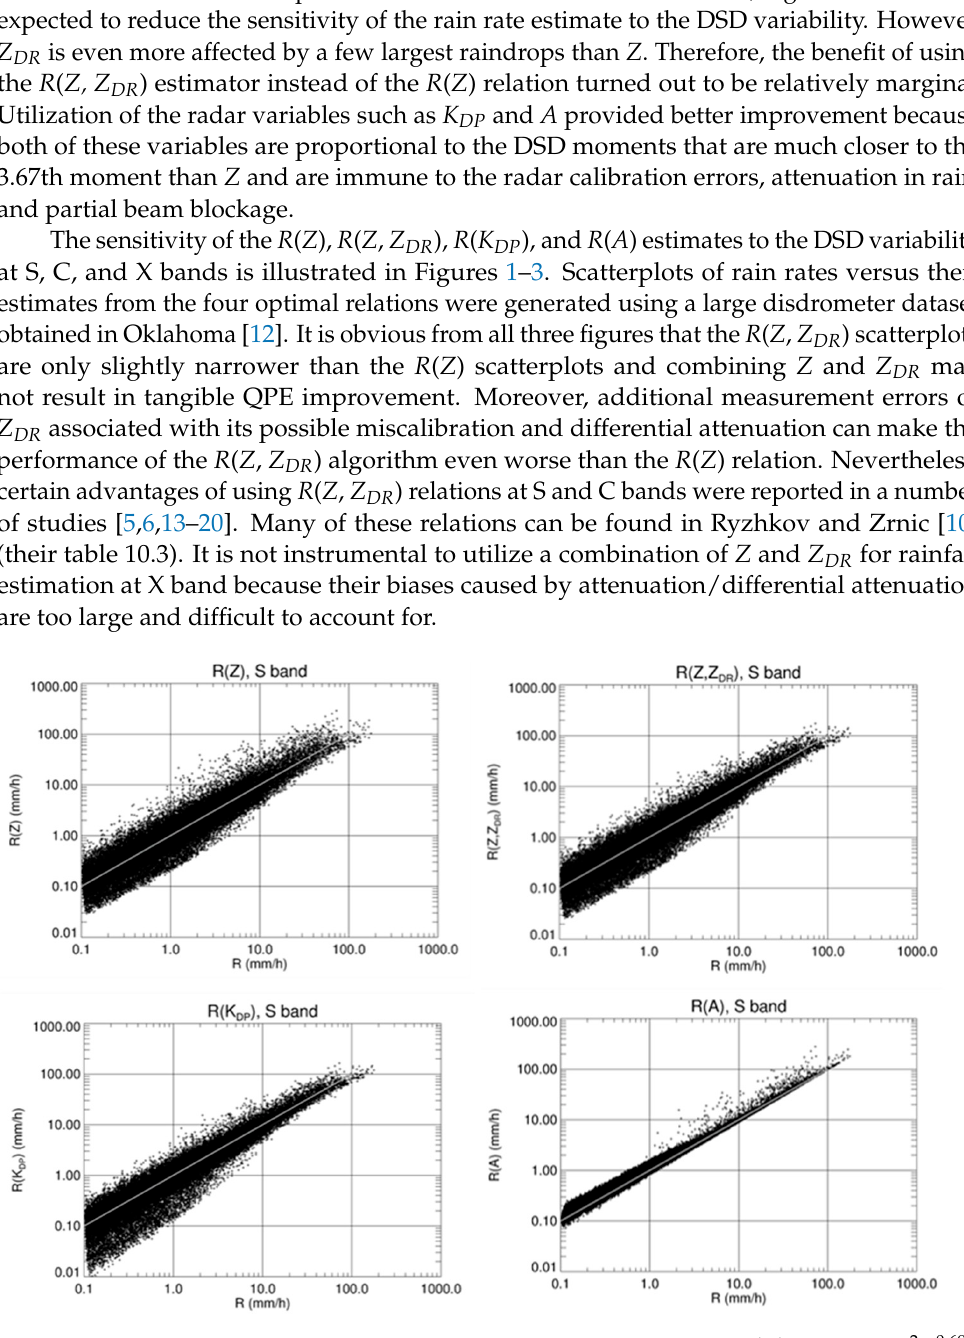
Figure 1. Scatterplots of rain rates versus their estimates from relations R ( Z ) = 1.94 10 − 2 Z 0.694 , R ( Z , Z DR ) = 1.66 10 − 2 Z 0.738 Z − 0.979 , R ( K DP ) = 47.1 K 0.790 , and R ( A ) = 4120 A 1.03 optimized for DP dr Oklahoma DSD dataset at S band ( λ = 11.0 cm) and T = 20 ◦ C. Z and Z DR are in a linear